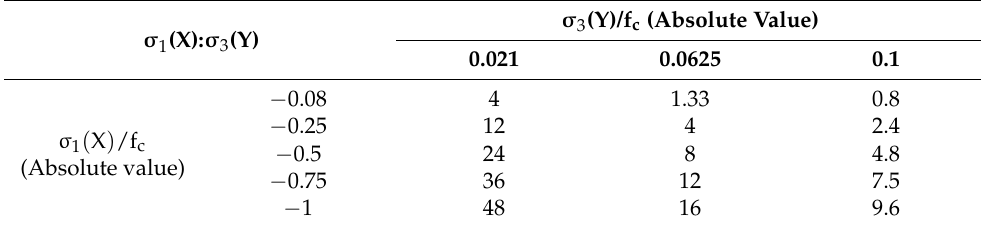
Table 5. Compressive/tensile stress ratio of the X- and Y-axis directions.